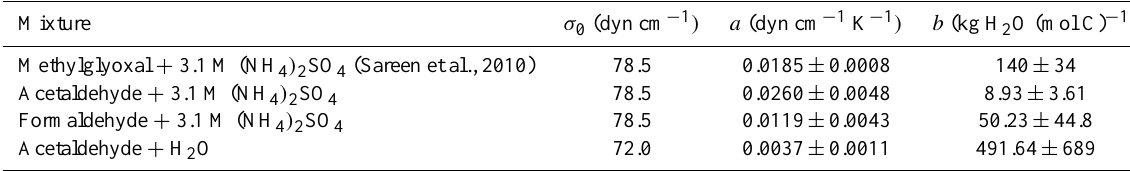
Table 1. Szyszkowski-Langmuir Fit Parameters according to Eq. (2).